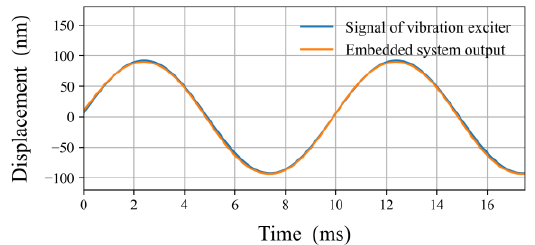
Figure 8. Comparison between the modulated signal of ω = 2 π × 100 and the output signal of the embedded system, after demodulation process and scaled to λ